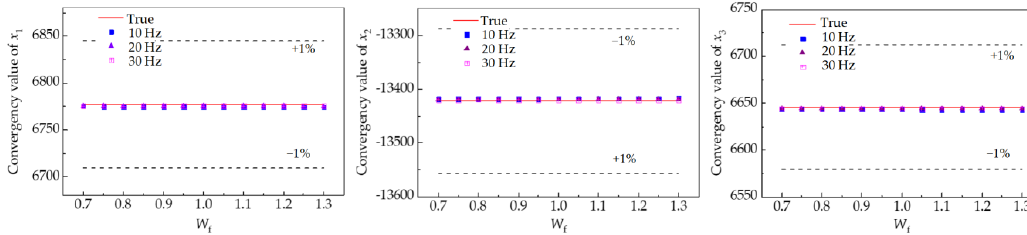
Figure 9. Effects of P 0 on the convergence values of system model parameters.